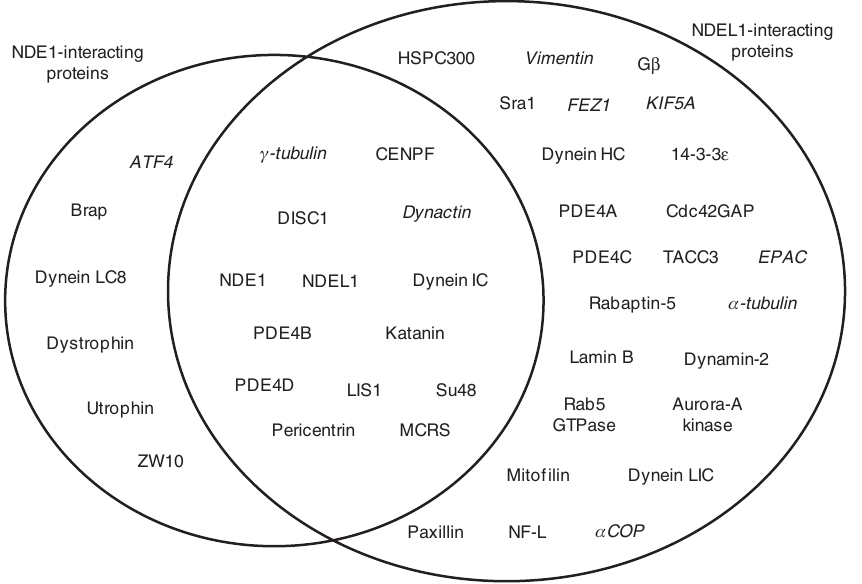
Figure 5 Protein interaction partners of NDE1 and